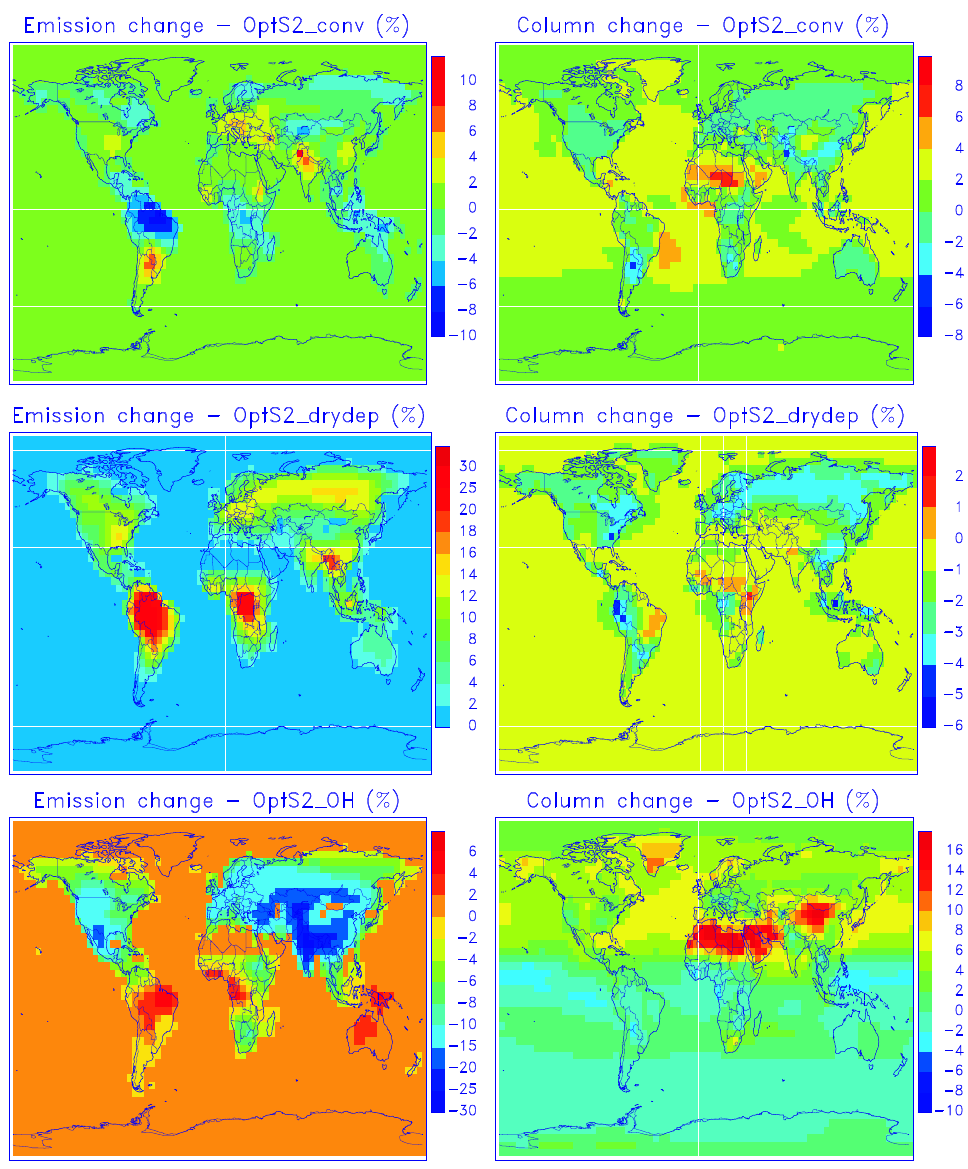
Fig. 13. Annual changes of the biogenic methanol emission (left) and methanol total column (right) derived from the three sensitivity inversions, OptS2-conv, OptS2-drydep, and OptS2-OH, described in Table 3, with respect to the standard OptS2 inversion. results are found to be only moderately different from those deduced with the standard OptS2 inversion (Fig. 15, Table 3). Overall, the inferred emission estimates are found to be quite robust in the different sensitivity cases, with global estimates differing by less than 10 %, although differences of the order of 30 % are found on the regional